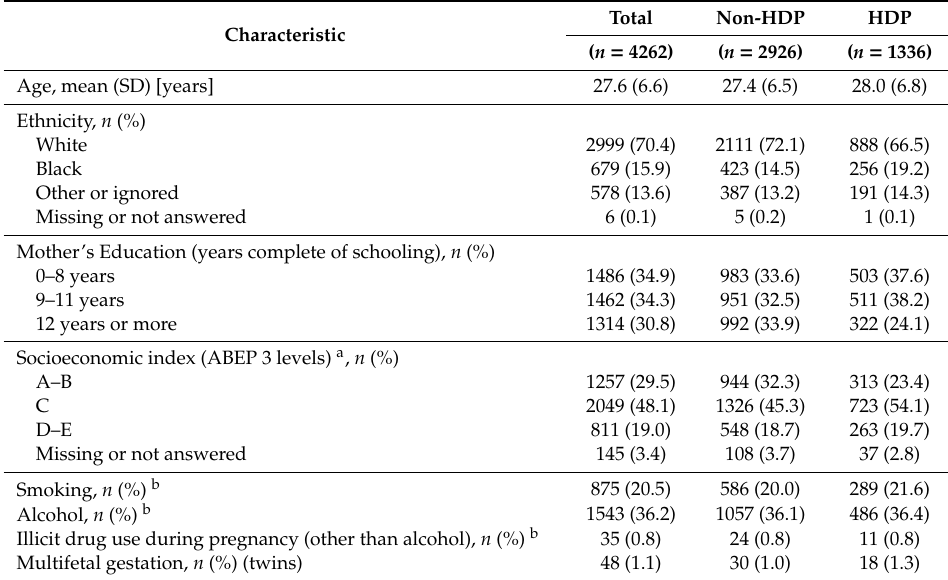
Figure 1. Flowchart of women included in the study. Abbreviation: HDP: Hypertensive disorder of pregnancy. Table 1. Baseline characteristics of women in the Pelotas cohort 2015, according to hypertensive disorders of pregnancy (HDP) ( n = 4262) *.